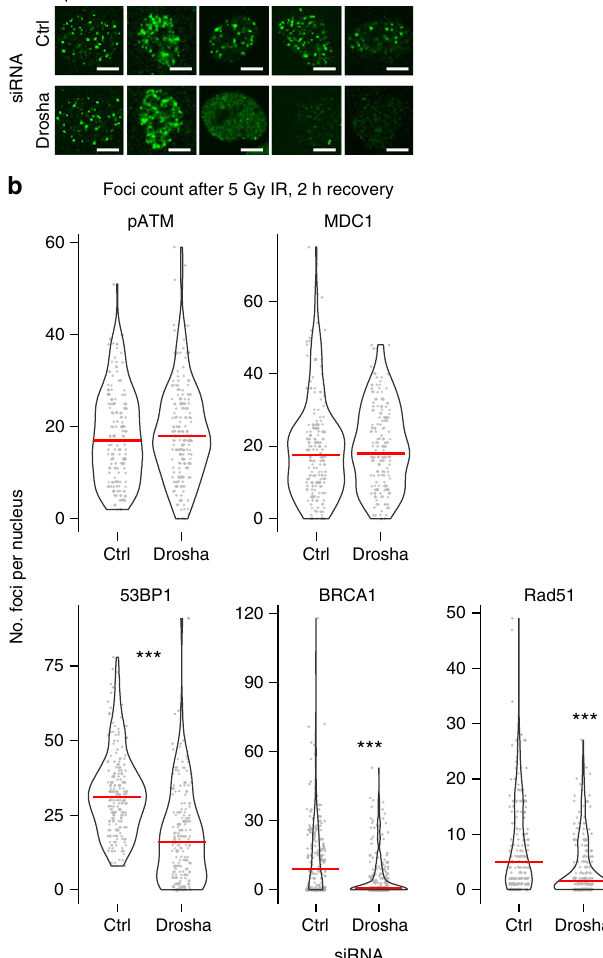
Fig. 2 Drosha is involved in DDR downstream of MDC1. a Representative immuno fl uorescence image visualizing IR-induced DDR foci in A549 cells, 2 h post 5 Gy IR. Scale bars, 10 µ m. b Quanti fi cation of a . Number of indicated foci per nucleus was counted as in Fig.1b across 3 biological replicates counting at least 60 cells per replicate. Red line denotes the median in each condition. Statistical signi fi cance determined using Mann- Whitney non-parametric test, *** p ≤